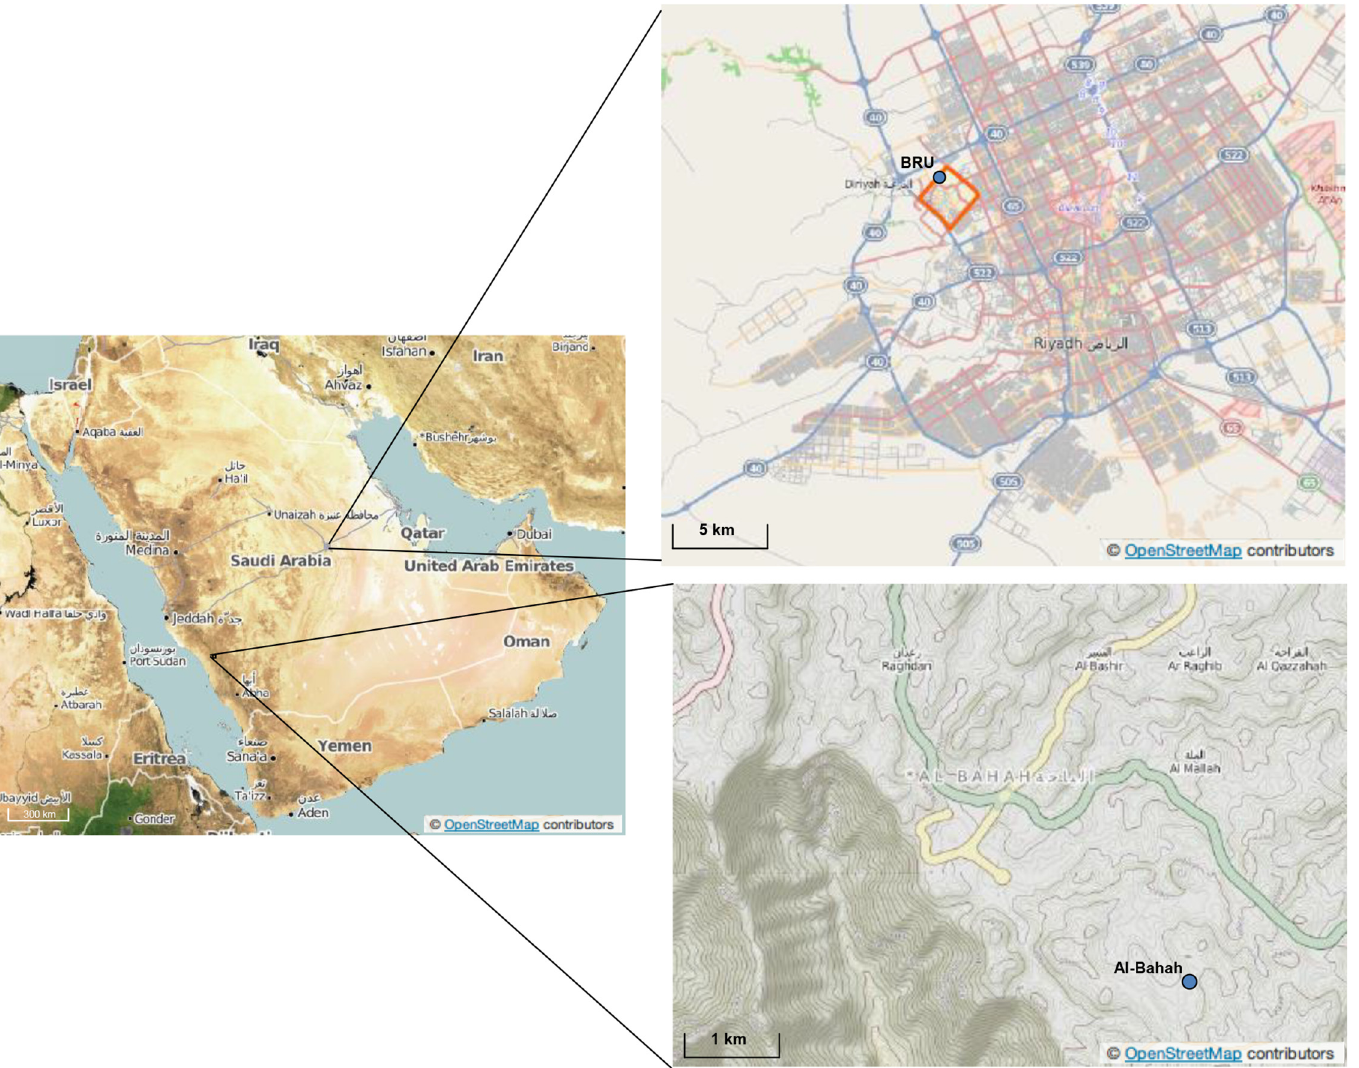
Fig 1. Map showing the location of the propolis sample collection in Riyadh (BRU) and Al-Bahah, Saudi Arabia ( “ OpenStreetMap contributors ” ,